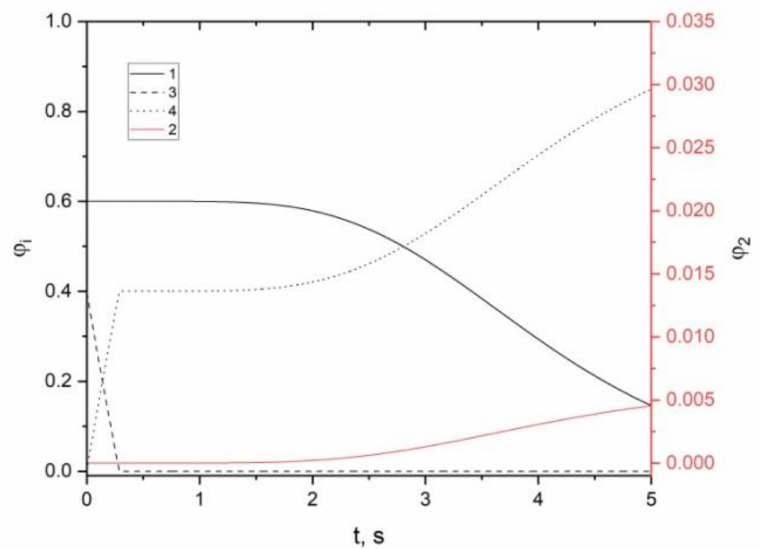
Figure 6. Distribution of volume fractions of phases under the influence of a low-intensity surface forest fire depending on time (summer, July, +20 ◦ C, ϕ 30 = 0.4, α s = 0.01): 1—dry organic matter, 2—soot particles, 3—moisture,